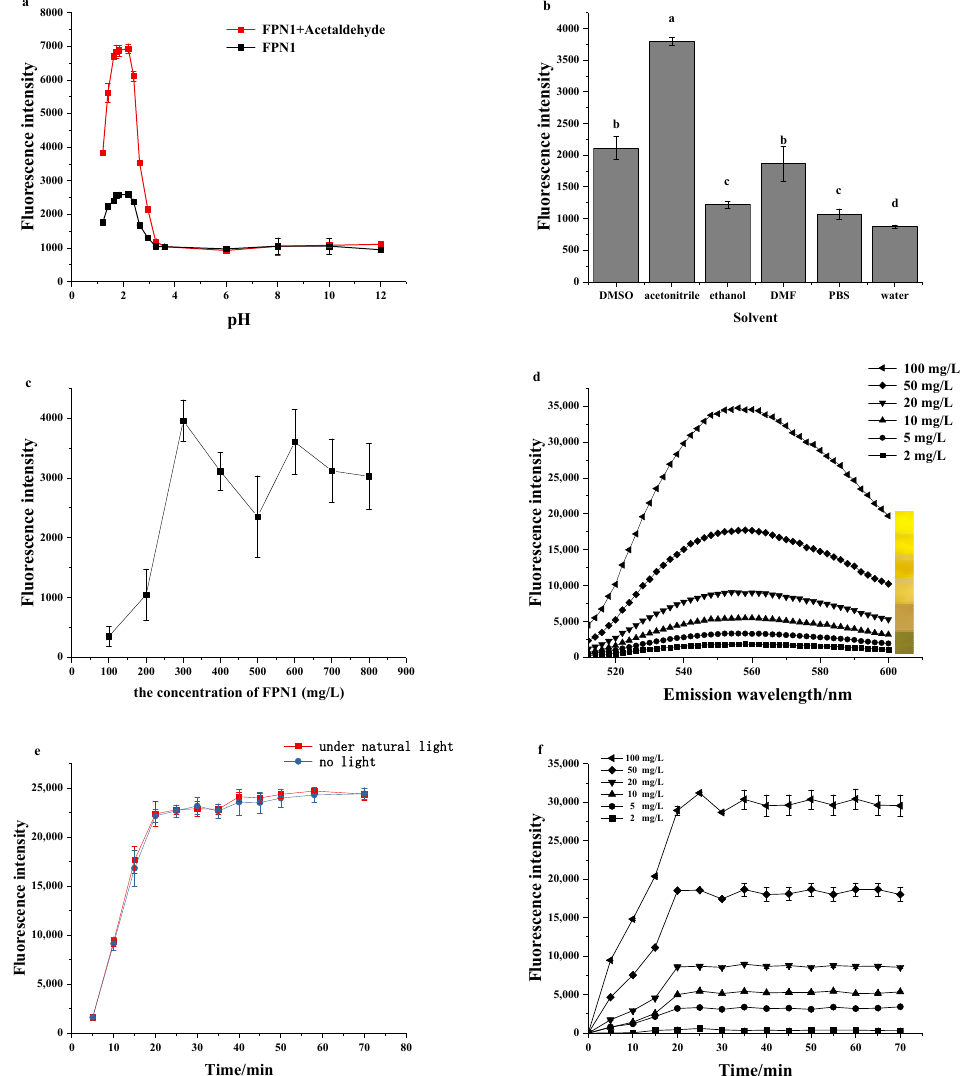
Figure 4. ( a ) Fluorescence intensity of FPN1 (300 mg/L) with and without acetaldehyde (10 mg/L) at different pH (1–12). ( b ) Fluorescence intensity of FPN1 (300 mg/L) in the presence of acetaldehyde (10 mg/L) in different solvents. Statistically significant differences were considered for p < 0.05. a,b,c,d : Values followed by the same letter do not differ significantly. ( c ) Fluorescence intensity of acetaldehyde (10 mg/L) in the presence of different concentrations of FPN1. ( d ) Fluorescence spectra of FPN1 (300 mg/L) in the presence of acetaldehyde (2, 5, 10, 20, 50, 100 mg/L). ( e ) Time-dependent fluorescence intensity changes of FPN1 (300 mg/L) in the presence of acetaldehyde (100 mg/L) with or without light. ( f ) Time-dependent fluorescence intensity changes in FPN1 (300 mg/L) in the presence of acetaldehyde (2, 5, 10, 20, 50, 100 mg/L). All tests were performed in